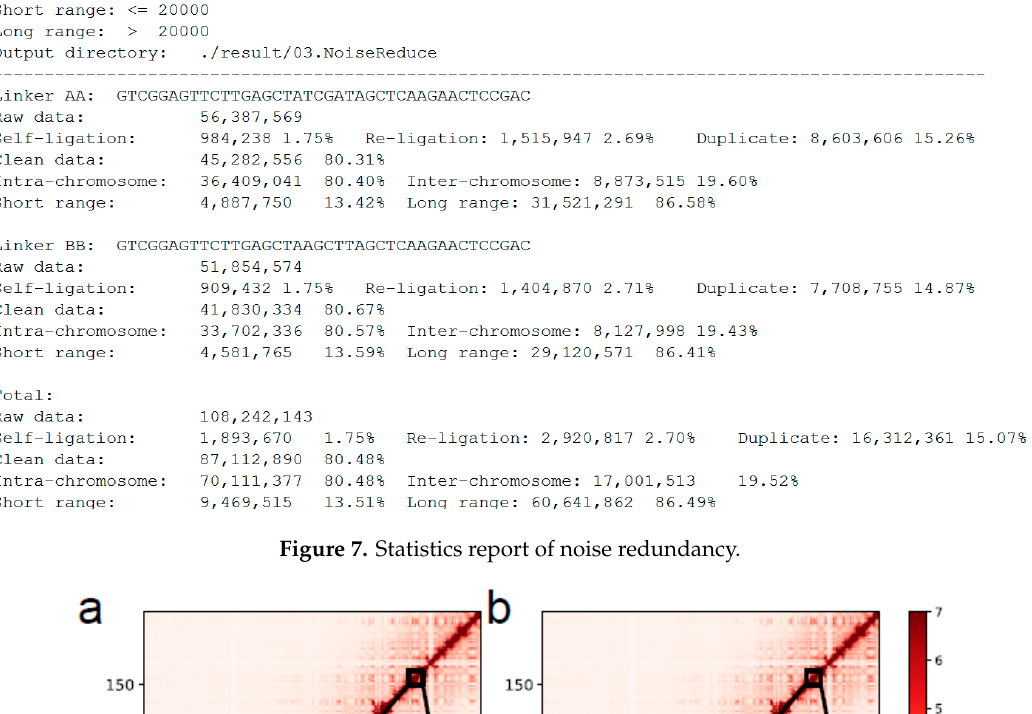
Figure 6. Statistics report of the alignment.